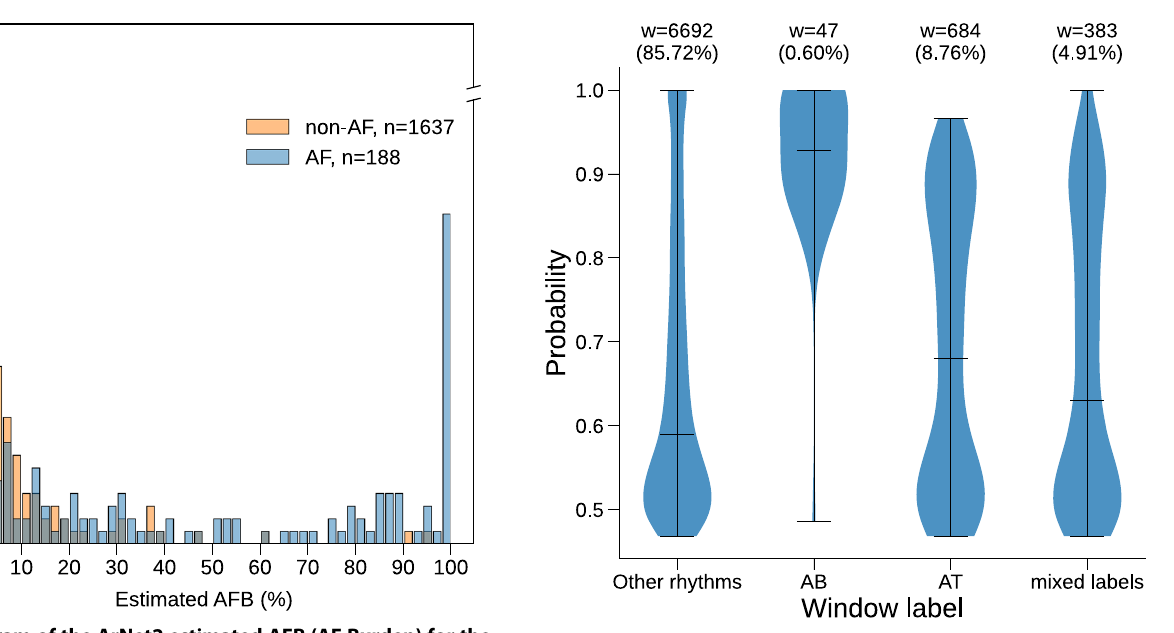
Fig. 5 The probability output of ArNet2 for the combined test set FP windows grouped to the true window labels. The represented rhythms shown in the violin plots are Other rhythms, Atrial Bigeminy (AB), Atrial Tachycardia (AT) and mixed labels. The mixed labels group consists of windows with AF l and other dominant rhythm so that the label of this window is non- AF l . w refers to the total number of FP windows in each violin plot while the proportion of FP windows for a given rhythm over the total number of FP windows is written in